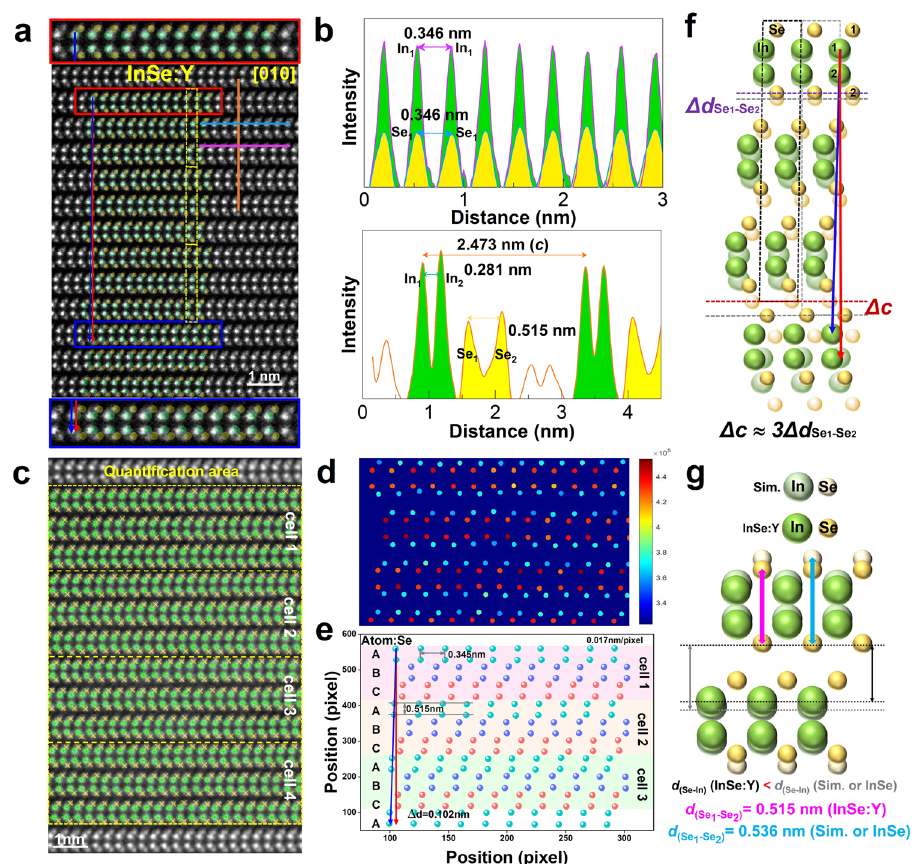
Fig. 4 | Microstructure analysis InSe:Y. a STEM-HAADF image of InSe:Y with magni fi edimagesatthetop(bottom)forthered(blue)rectangles.Thesimulated γ - InSe atomic arrangements with green (yellow) dots representing In (Se) atoms are overlaid on the HAADF image, which demonstrates the continuous slip behavior layer-by-layer,as tracedby the red (blue) arrows. b Intensity line pro fi lesextracted from a with the upper along the horizontal purple (In 1 – In 1 ) and sky-blue (Se 1 – Se 1 ) lines and the lower along the vertical orange line. c Atomic positions of In (green stars) and Se (yellow crosses) identi fi ed by Calatom software. d Normalized